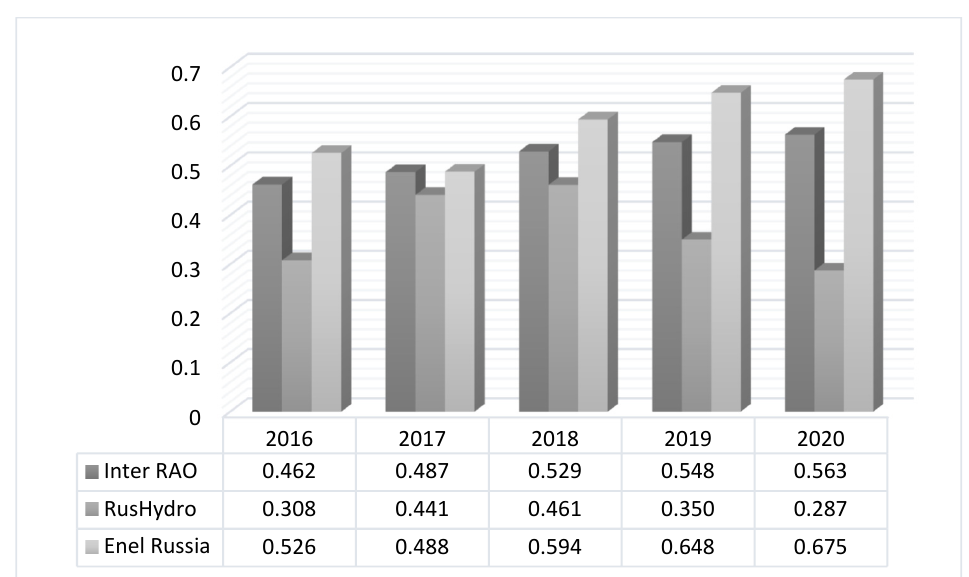
Figure 7. Dynamics of the level of development of the studied multinational corporations. Source: generated by the authors.